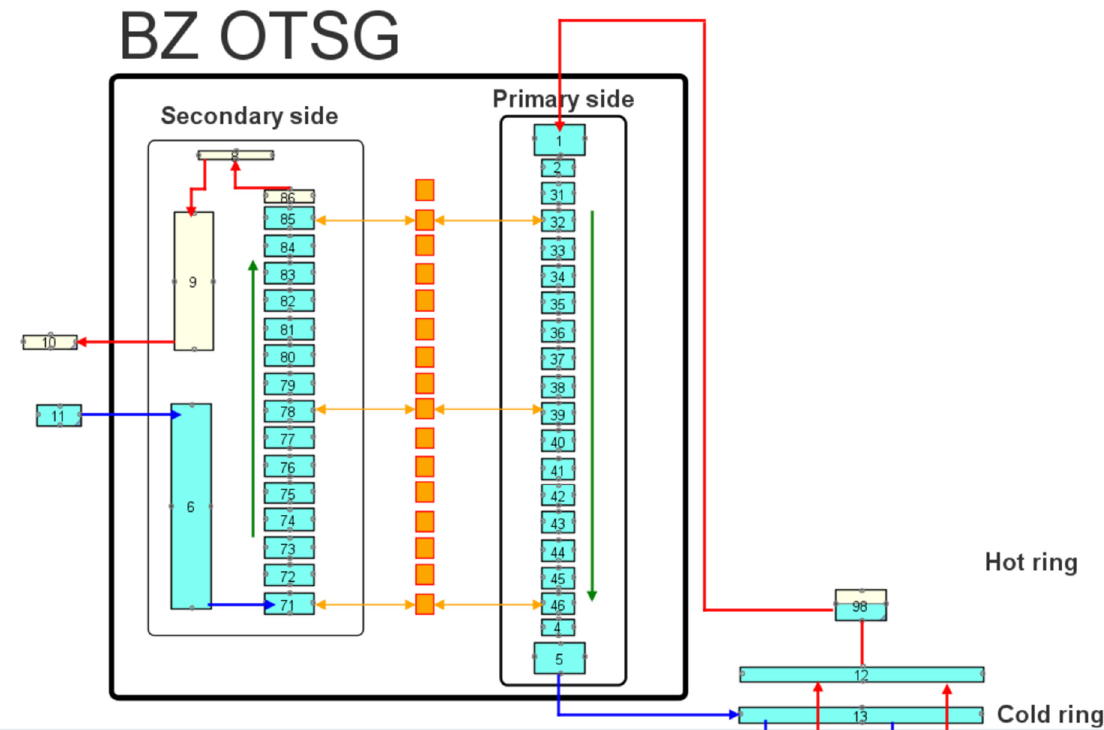
Figure 4. Detail of BZ OTSG nodalization.